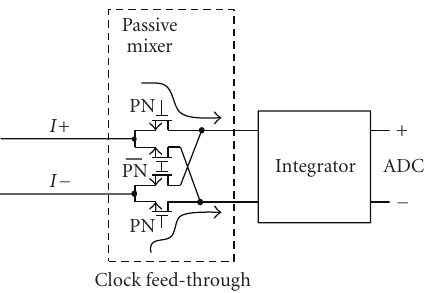
Figure 6: Clock leakage into the integrators from the clock of the PN generators.